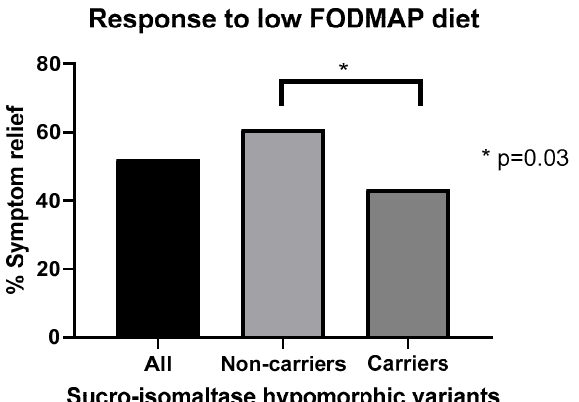
Figure 3. Impact of sucrose-isomaltase genetic variants which reduce enzyme activity. Repro- duced with permission from Zheng et al.